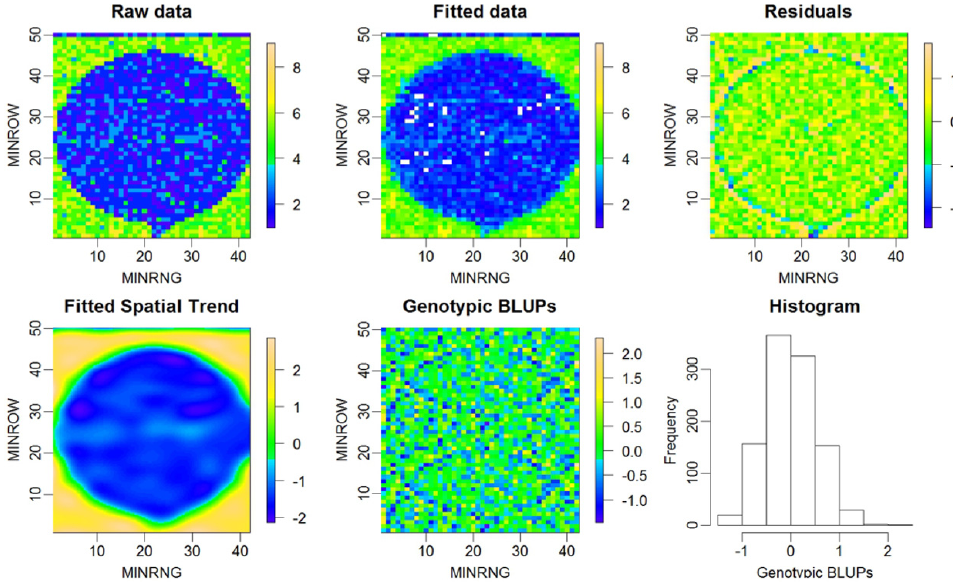
Figure 4. Heatmaps and histogram from data set 1 by P-spline via SpATS. The rectangle layout is 42 rows ( X -axis) by 50 ranges ( Y -axis) with a total of 2100 plots for each of the five heatmaps. Best linear unbiased prediction (BLUP) is the best linear unbiased prediction value or genetic effect for each line tested, which ranges from − 2 to +2. Sub-figure variants are indicated by headings—for example, the Residuals sub-figure shows values after application of P-spline to fitted data.